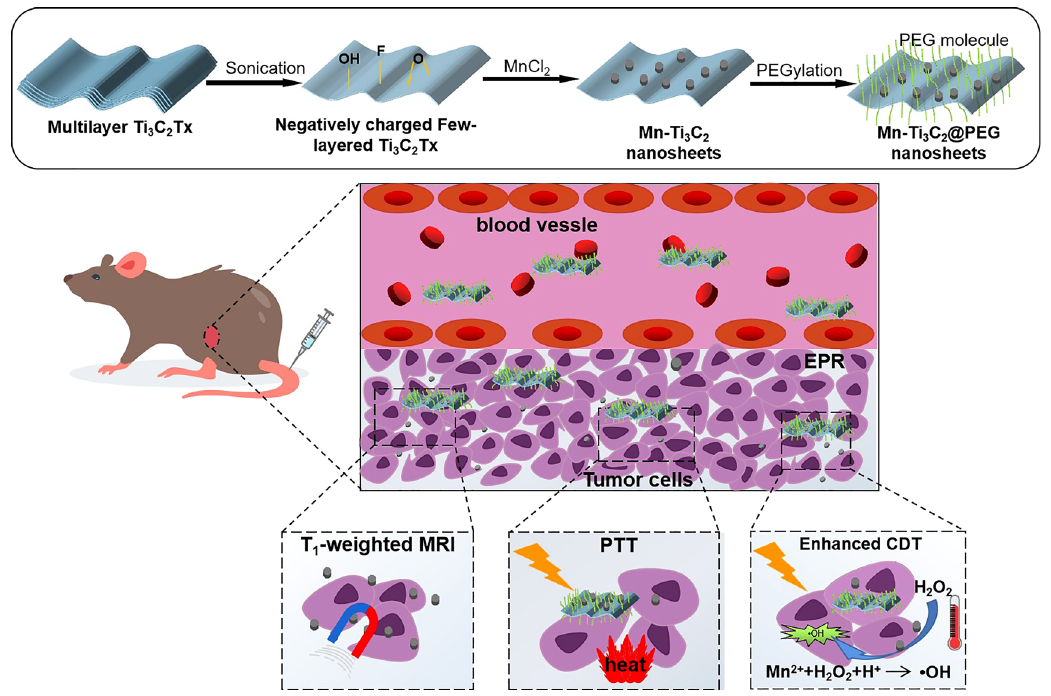
Scheme 1: Schematic illustration of the synthetic procedure and MRI-guided efficient photothermal and chemodynamic tumor therapy by C Mn-Ti 3 2